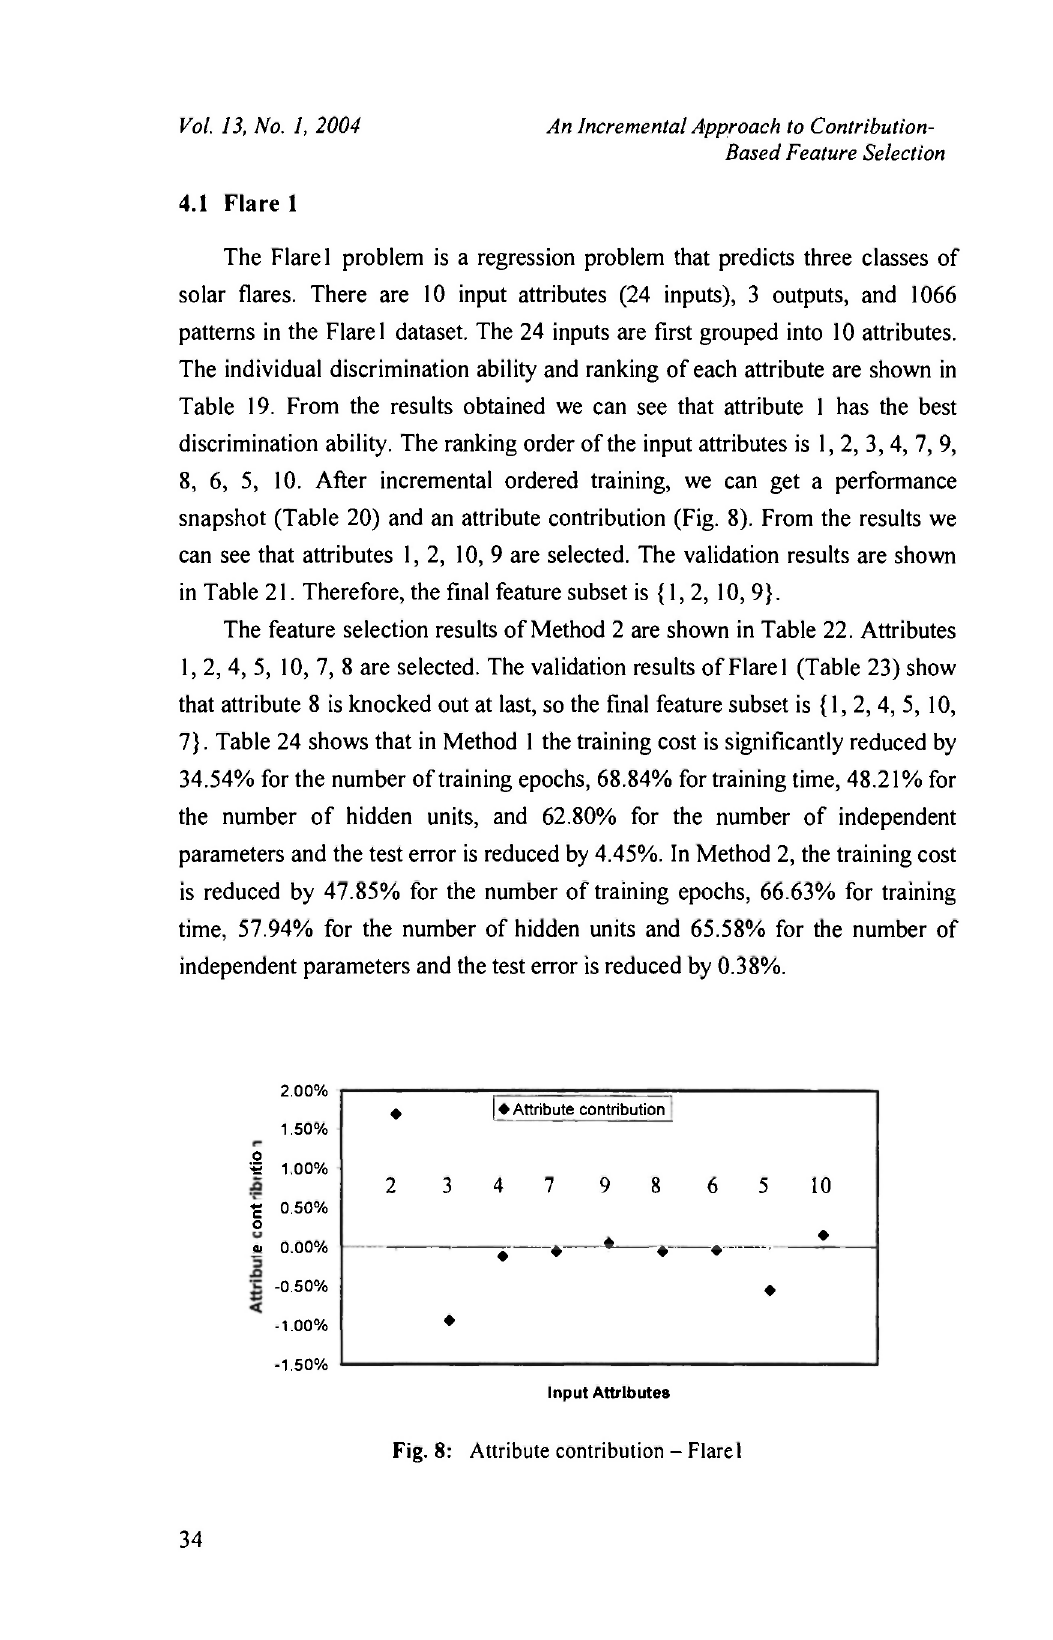
Fig. 8: Attribute contribution - Flare